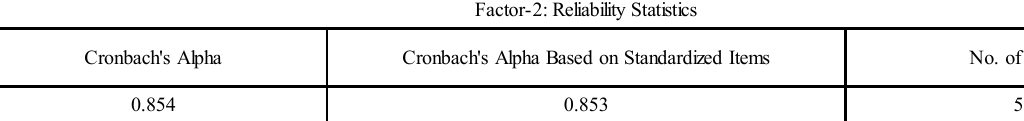
TABLE 22. FACTOR-3; DETAILS OF INTER-ITEM CORRELATION MATRIX